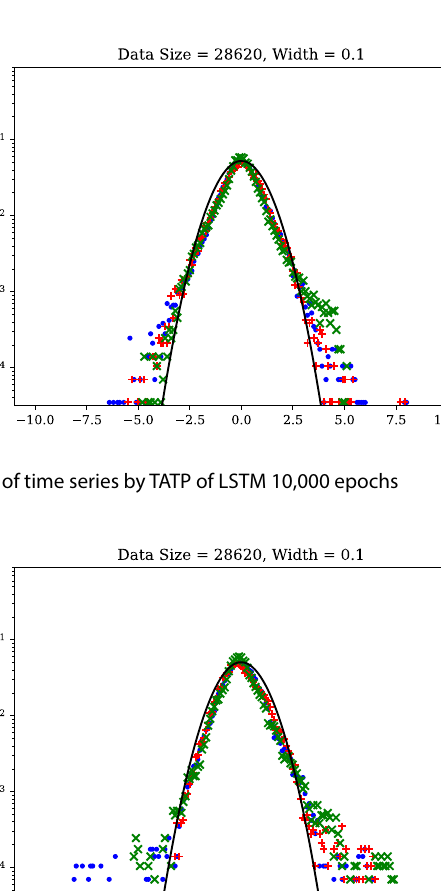
Fig. 9 PDF of time series by TATP of SRNN 300 epochs